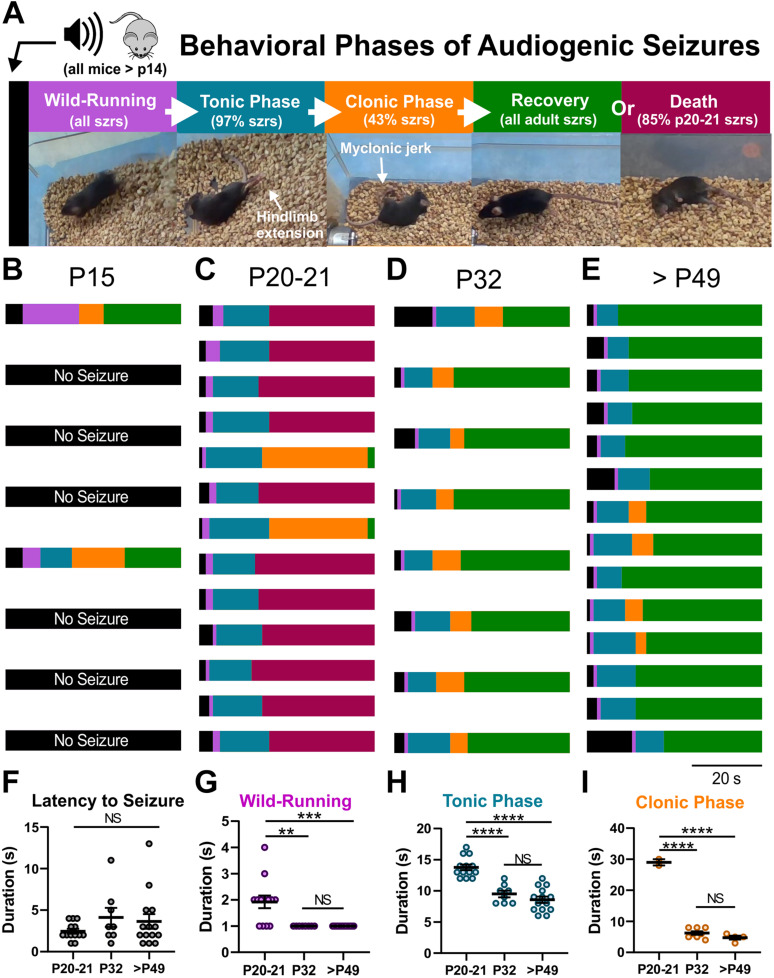
Audiogenic seizures and sudden death in D/+ mice. (A) In response to high-intensity acoustic stimulation, D/+ mice exhibit wild-running (purple), a tonic phase characterized by hindlimb extension (teal), a clonic stage (orange) characterized by rapid kicking of the hindlimbs, and recovery (green) as the animal rights itself and resumes normal movement throughout the cage, or sudden death (magenta). Audiogenic seizure behavioral progression in each mouse at developmental time points P15 (B), P20-21 (C), P32 (D), and P49-P69 (E). (B) Only 2 of 8 D/+ mice at P15 exhibited audiogenic seizures. (C) All 13 D/+ mice at P20-21 experienced audiogenic seizures, and 11 of 13 died directly following the tonic phase. The 2 that recovered did so after a relatively extended clonic phase. (D) At P32, all 8 D/+ mice had audiogenic seizures and recovered. (E) In adult D/+ mice (P49-P69), all mice experienced seizures followed by recovery. Duration of seizure phases, latency to seizure onset (F), wild-running (G), tonic phase (H), and clonic phase (I) for D/+ mice ages P20-21 (n = 13), P32 (n = 8), and P49-P69 (14). **, ***, ****, and NS indicate P < 0.01, 0.001, 0.0001, >0.2, respectively, for post hoc comparison between age groups.